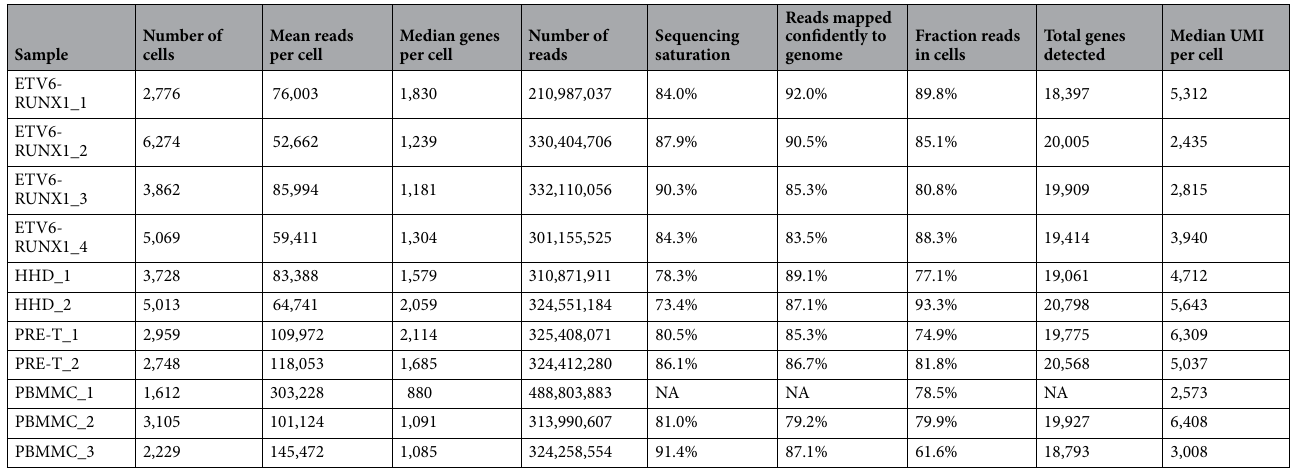
Table 2. A correct version of the original Table